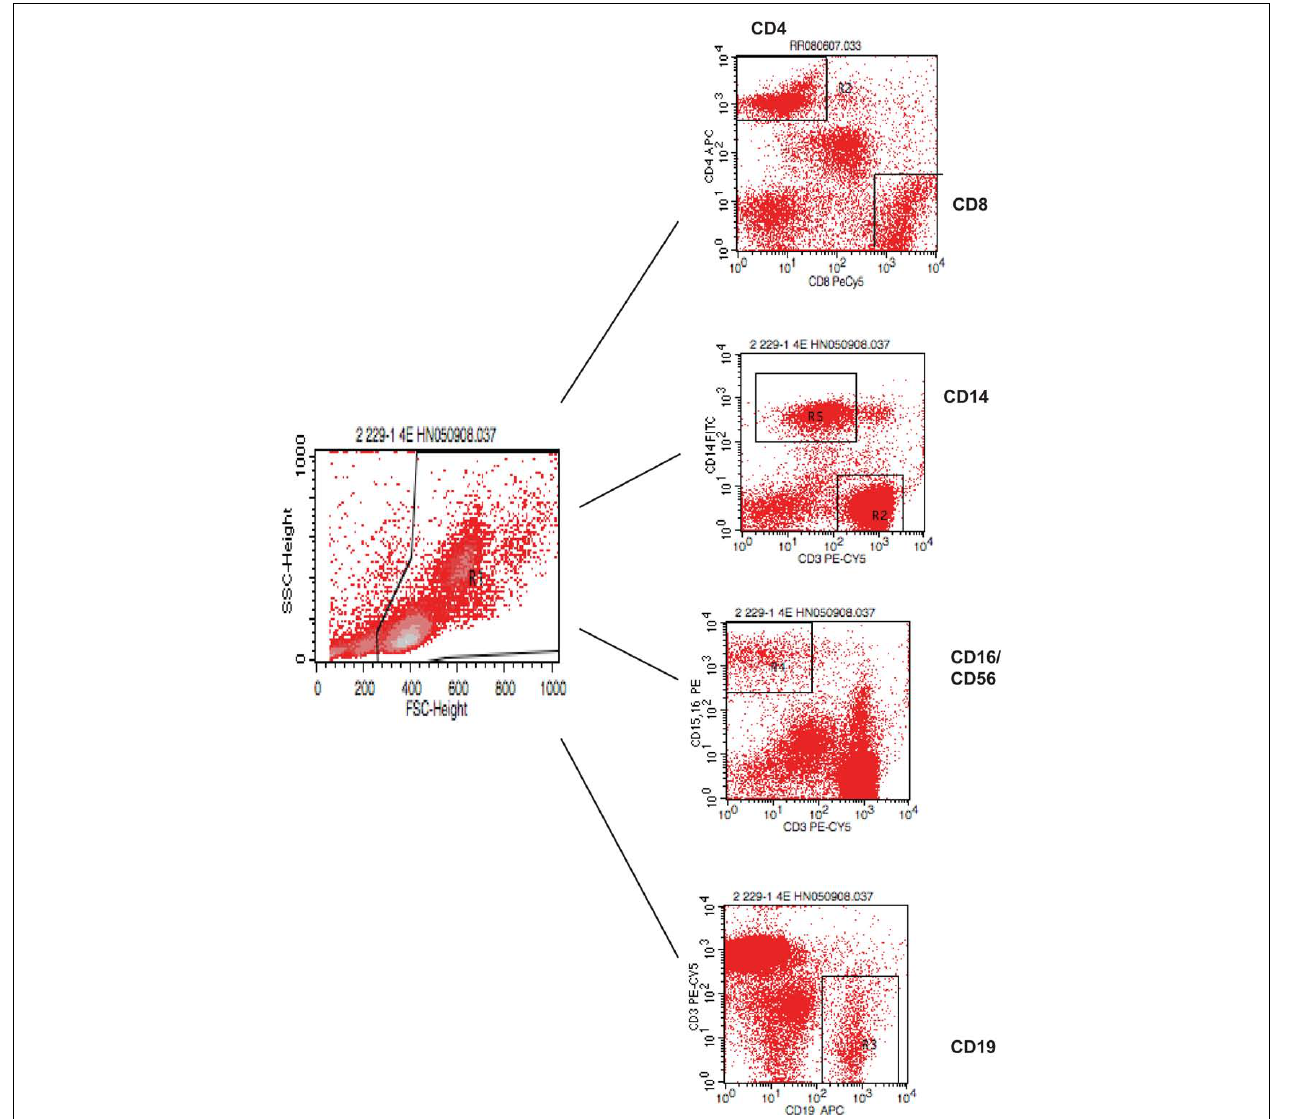
FIGUREA1 | Gating strategy for flow cytometry analysis of blood lymphocytes. PBMC were isolated and stained with various antibodies and analyzed by FACS.